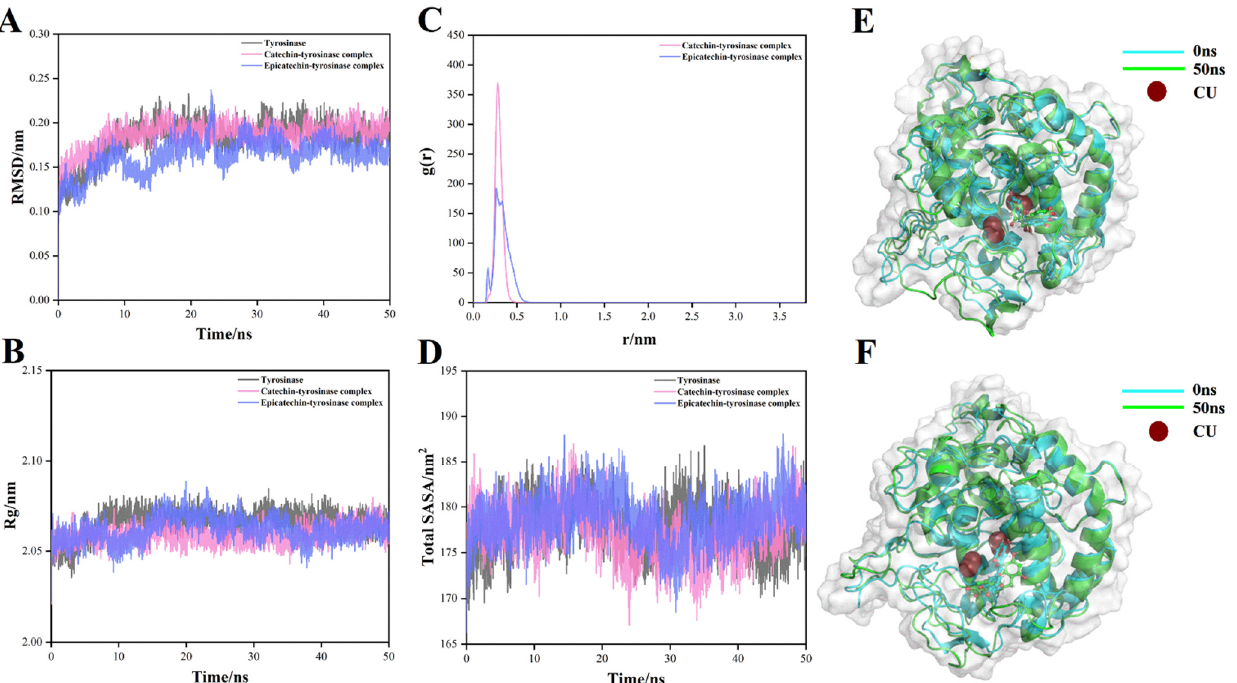
Figure 7. Molecular dynamics (50 ns) results of tyrosinase with (+)-catechin and ( − )-epicatechin. ( A ) Root mean square deviation (RMSD, nm), ( B ) Radius of rotation (Rg), ( C ) Radial distribution function (RDF), and ( D ) Solvent accessible surface area (SASA) values. The molecular dynamics results of (+)-catechin-tyrosinase and ( − )-epicatechin-tyrosinase system at 0ns and 50ns, respectively ( E , F